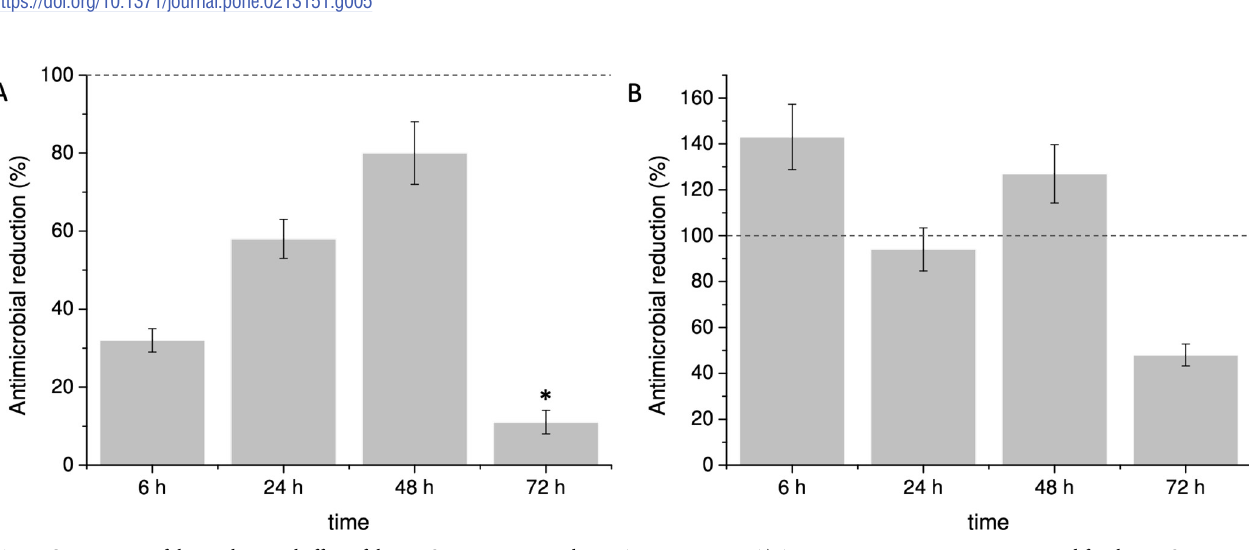
Fig 6. Comparison of the antibacterial effect of the MoO 3 NP coating with two Ag NP coatings: A) Ag 100% —same NP concentration used for the MoO 3 NP coating; B) Ag 50% —half NP concentration. � denotes significant change (p <